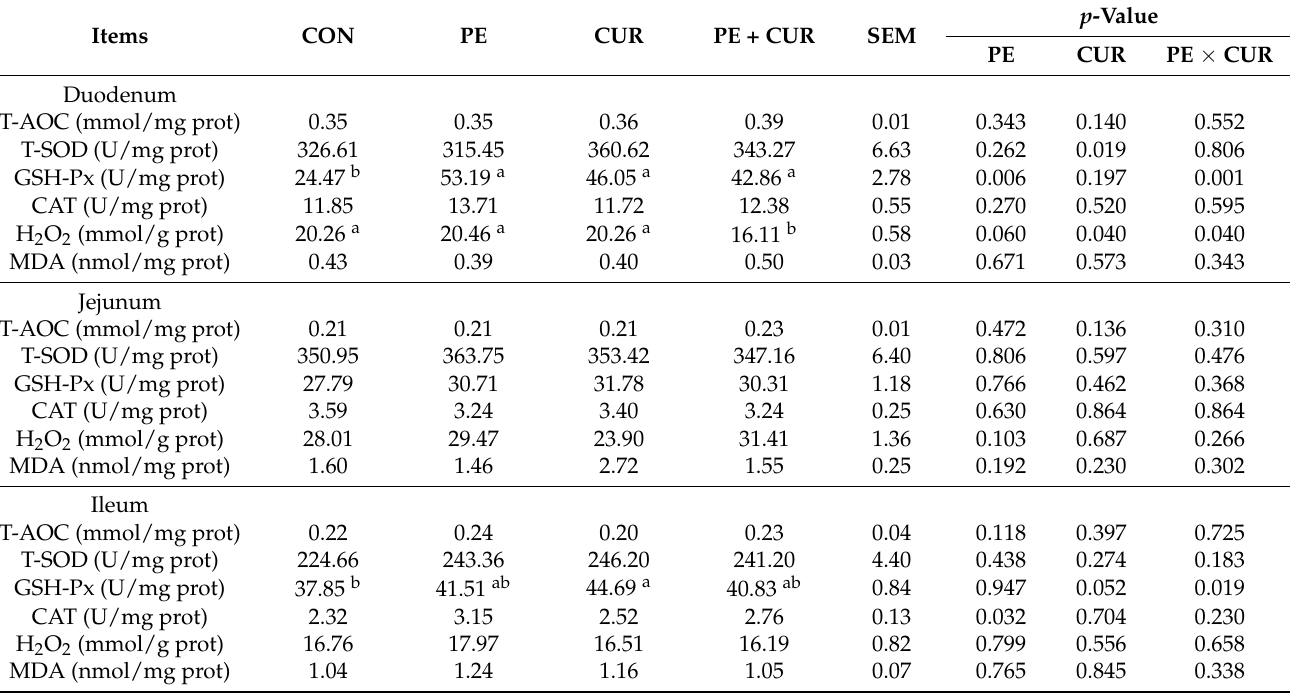
Table 5. Effects of dietary supplementation with PE and CUR on antioxidant status in small intestine of broilers 1